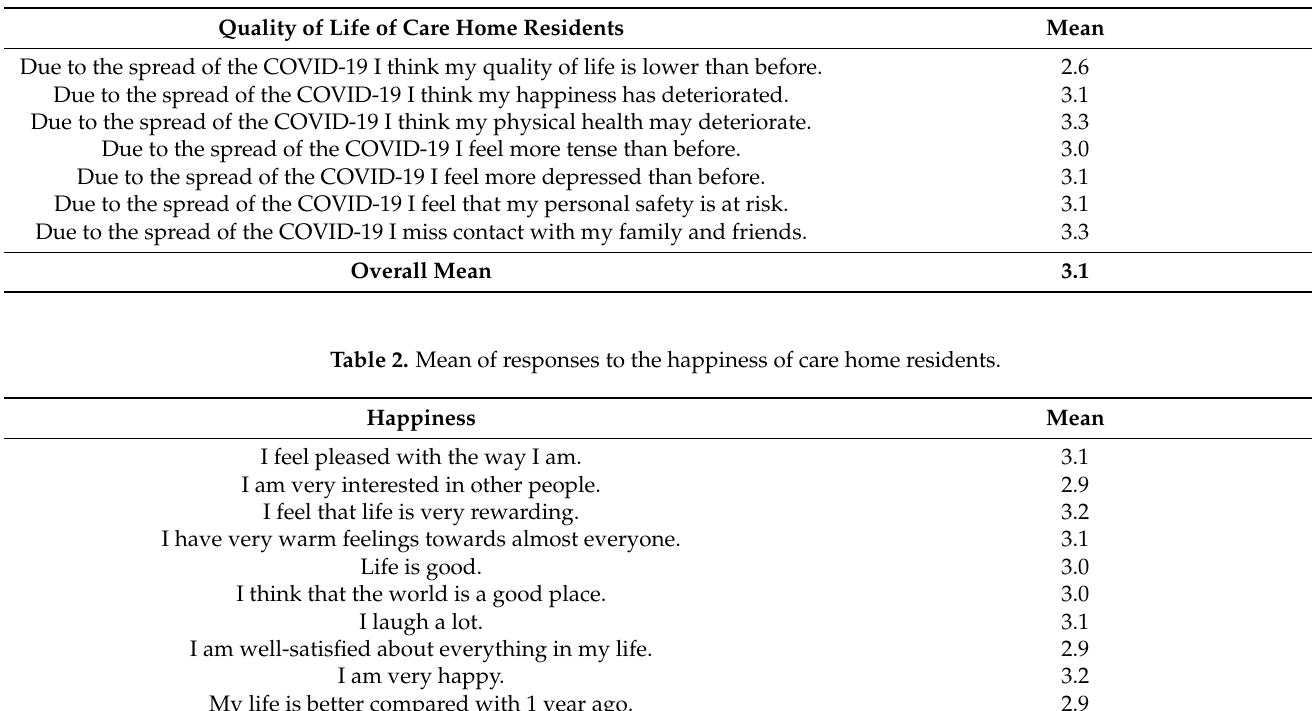
Table 1. Mean responses to the Quality of Life of care home residents.